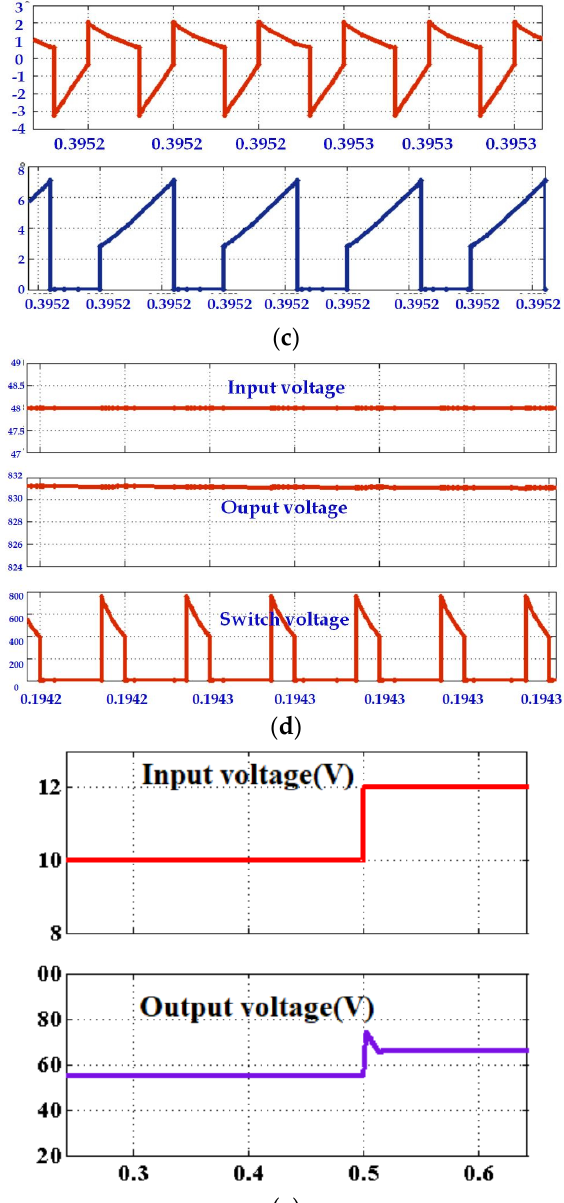
Figure 13. Comparative analysis. Key simulation results of HSIVL converter at 50 Watts. ( a ) Simulated voltage waveform, ( b ) Simulated inductor and diode current waveform, ( c ) Capacitor and switch current waveform, ( d ) Input, output, and switch voltage with N = 3 and D = 0.7 for higher voltage application. ( e ) Input and Output voltage with step